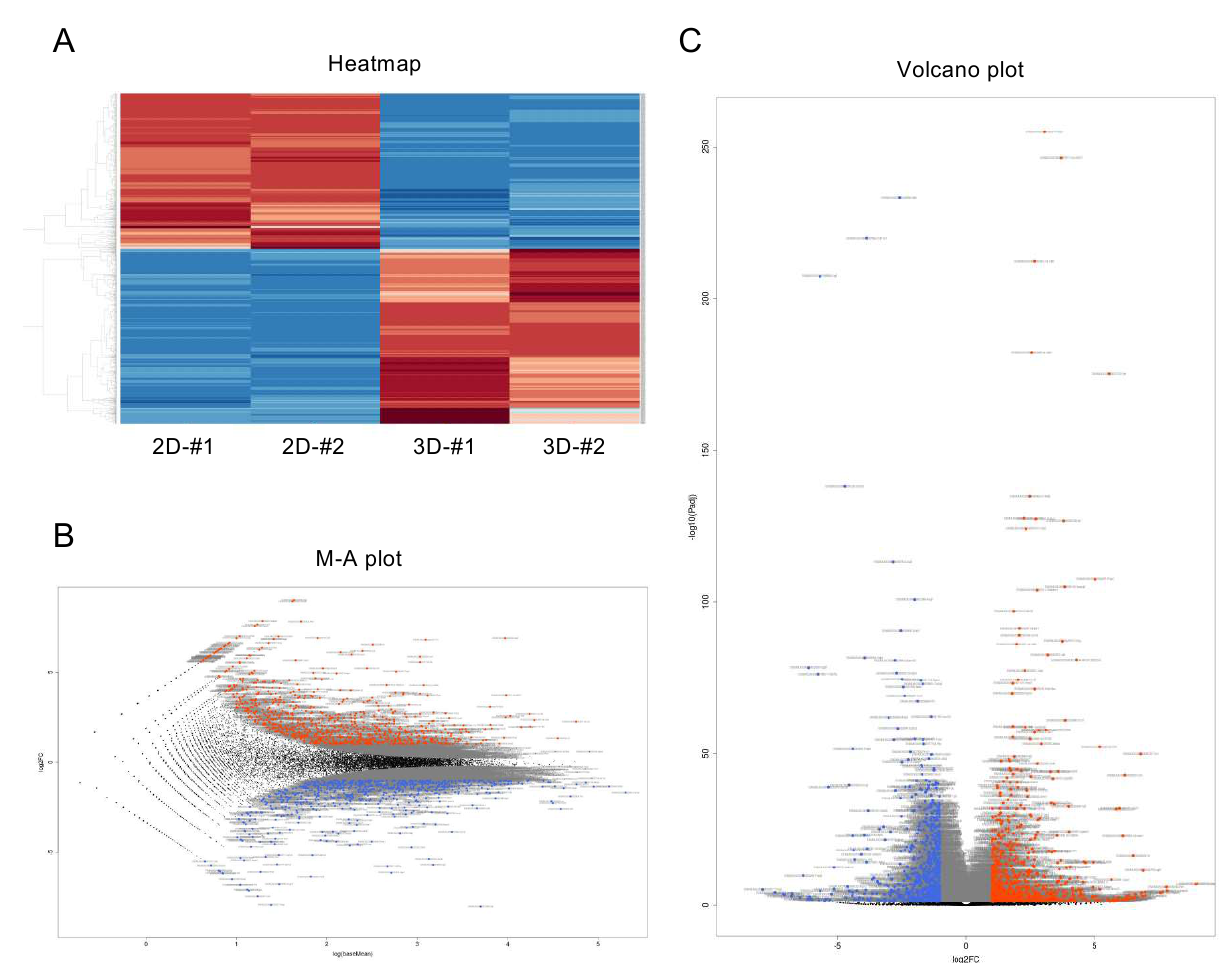
Figure 2. Differentially expressed genes (DEGs) between 2D- and 3D-cultured 3T3-L1 cells. Genes that are expressed differentially between 2D- and 3D-cultured 3T3-L1 cells were demonstrated by a hierarchical clustering heatmap ( A ), an M–A plot ( B ), and a volcano plot ( C ). M–A plot represents relationship between mean expression values (log (base mean); x axis) and magnitude of gene expression change (log2 of fold change; y axis), and volcano plot represents the relationship between the magnitude of gene expression change (log2 of fold change; x axis) and statistical significance of this change (−log10 of false discovery rate (FDR); y axis). Colored points represent differentially expressed genes (cutoff FDR < 0.05) and/or the magnitude of change ≥ 2 that are either overexpressed (red) or underexpressed (blue) in 2D-cultured, compared with 3D-cultured 3T3-L1 cells.